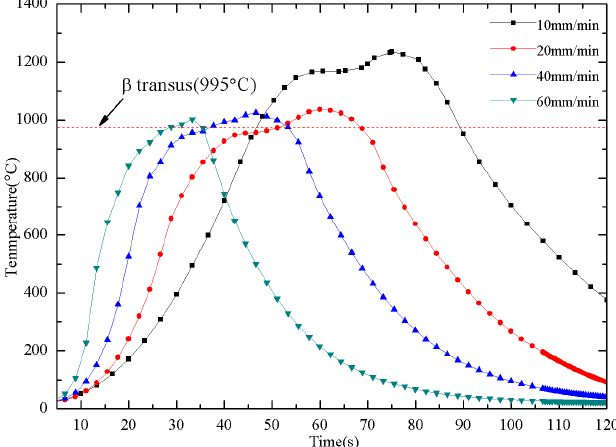
Figure 7. Temperature history profiles at various welding speed (all at rotational speed of 1100 rpm).